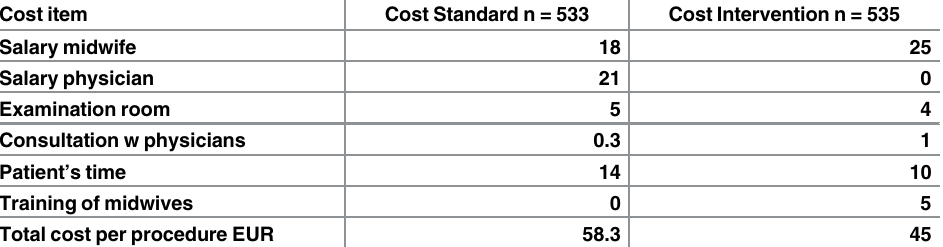
Table 1. Direct costs of standard and intervention treatment, per procedure, 2011